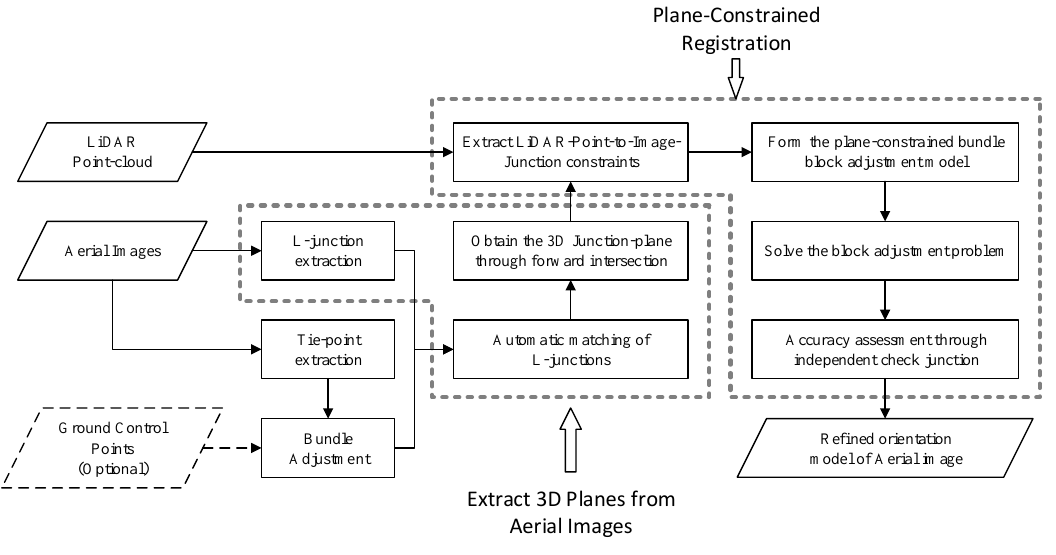
Figure 1. Workflow of the proposed